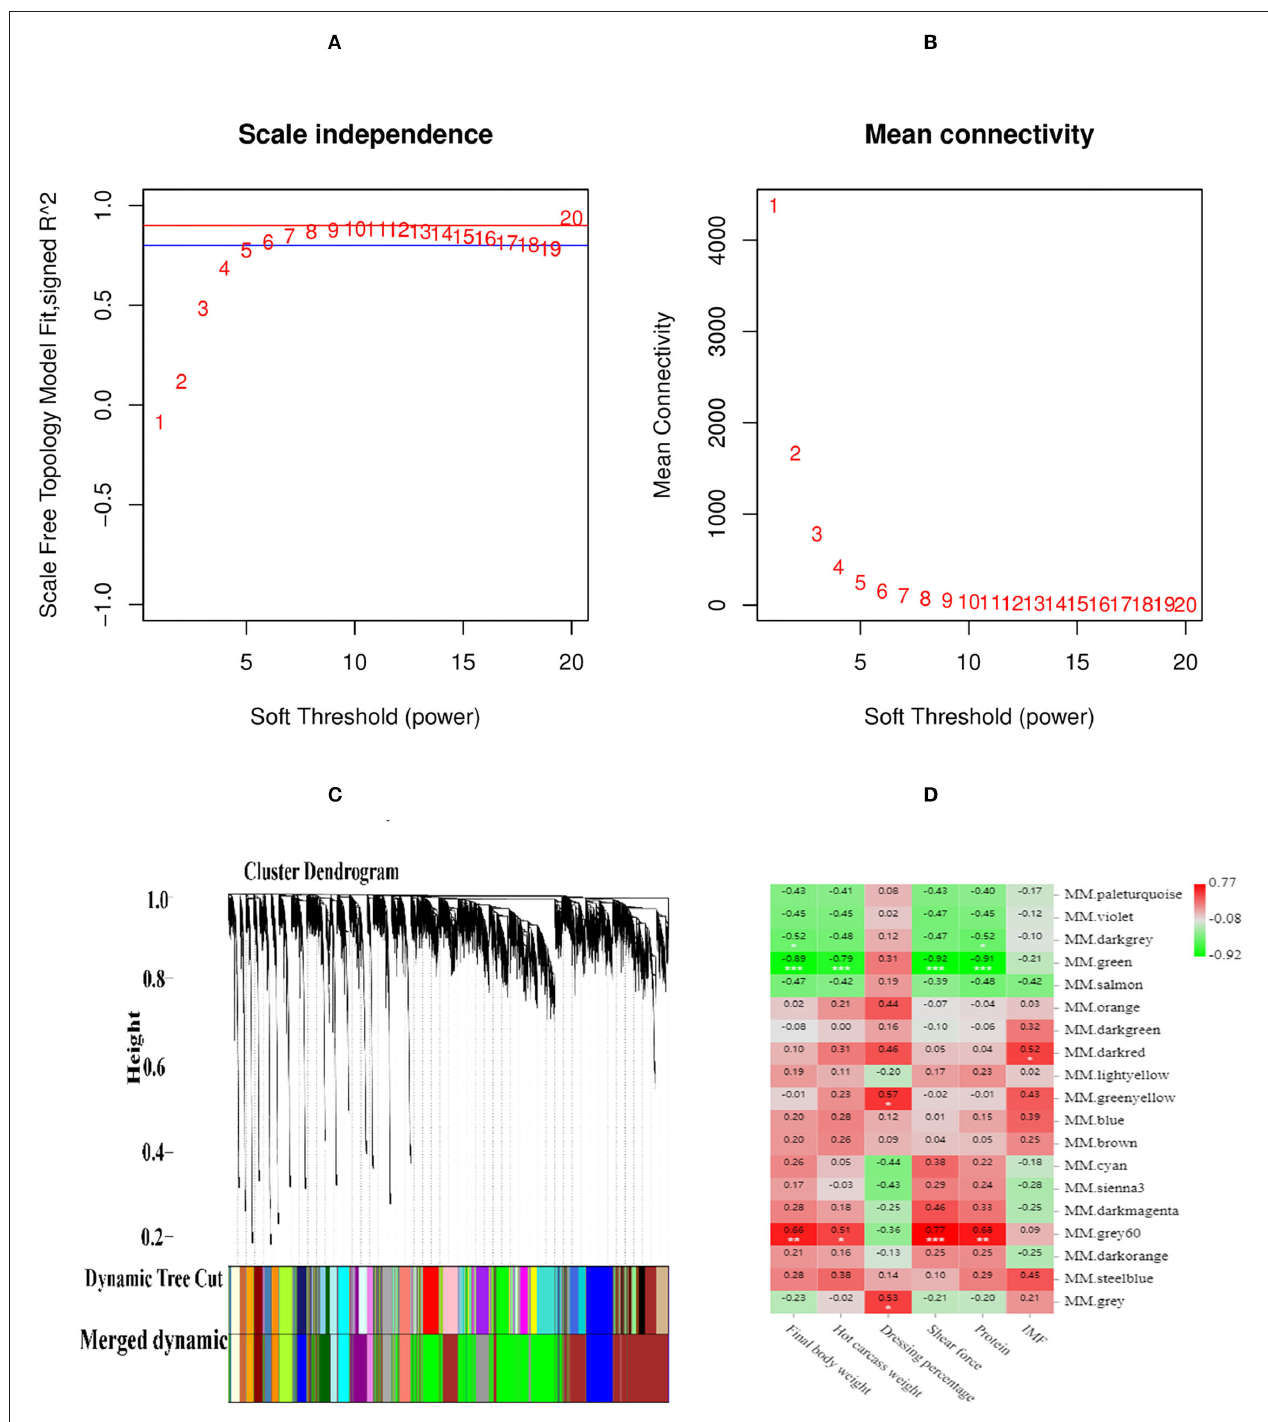
FIGURE 4 | The scale-free fit index and mean connectivity of WGCNA. (A) Abscissa represents the soft threshold (power value, β ). Ordinate represents the correlation coefficient R 2 . Blue horizontal line represents the correlation coefficient R 2 = 0.8, red horizontal line represents the correlation coefficient R 2 = 0.9. (B) Abscissa represents the soft threshold (power value, β ), Ordinate represents the mean connectivity. (C) Clustering tree (dendrogram) defined by WGCNA representing the co-expression modules. Branches of the dendrogram correspond to modules labeled with different colors below the dendrogram. (D) Correlation between modules and meat quality and slaughter trait according to Pearson